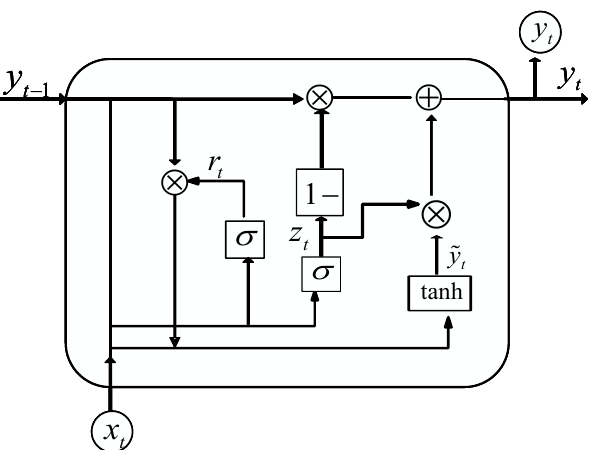
Figure 3. Gated recurrent unit (GRU) architecture (a single memory block is shown for